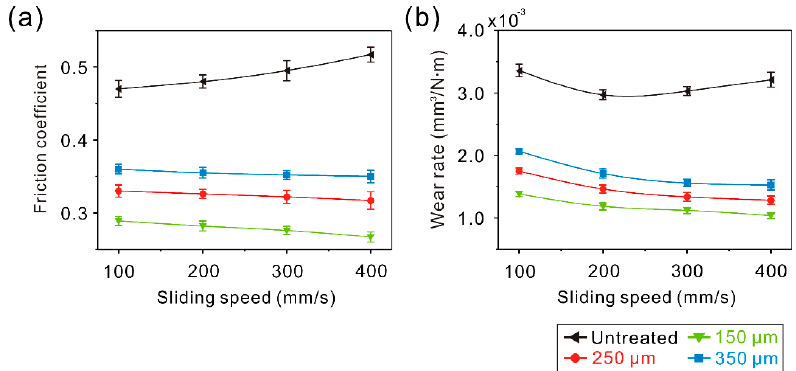
Figure 14. Variation of ( a ) the friction coefficient and ( b ) the wear rate of the AGS with sliding speed (load of 0.3 N, sliding speed of 100 mm/s, frictional pair of GCr15 bearing steel, friction time of 10 min).